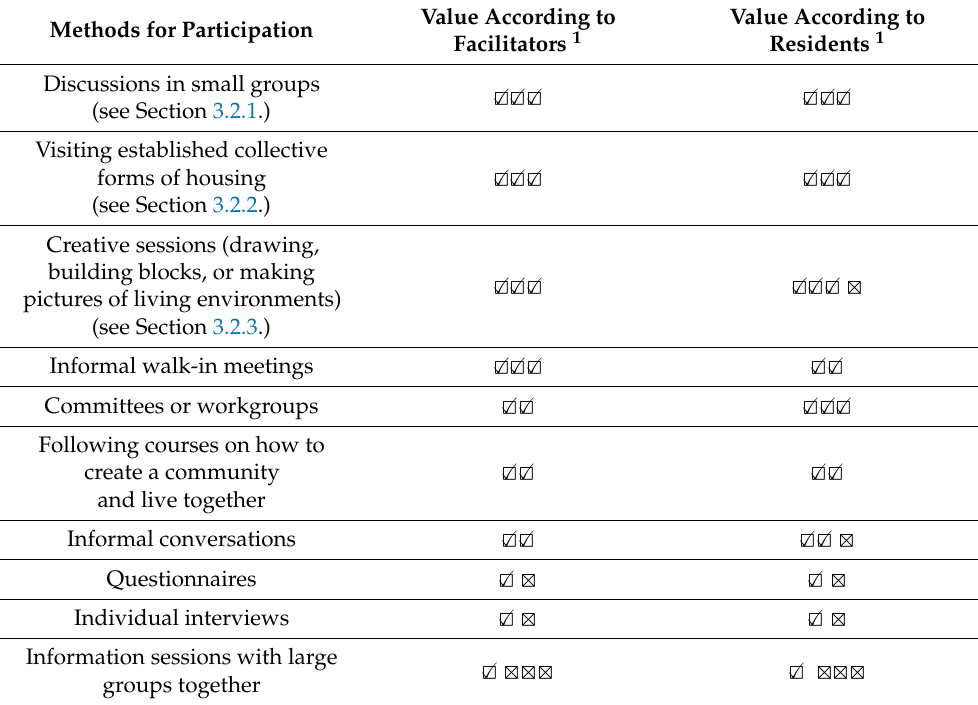
Table 2. Overview of methods used to initiate participation in the concepting and design phase. Methods for Participation